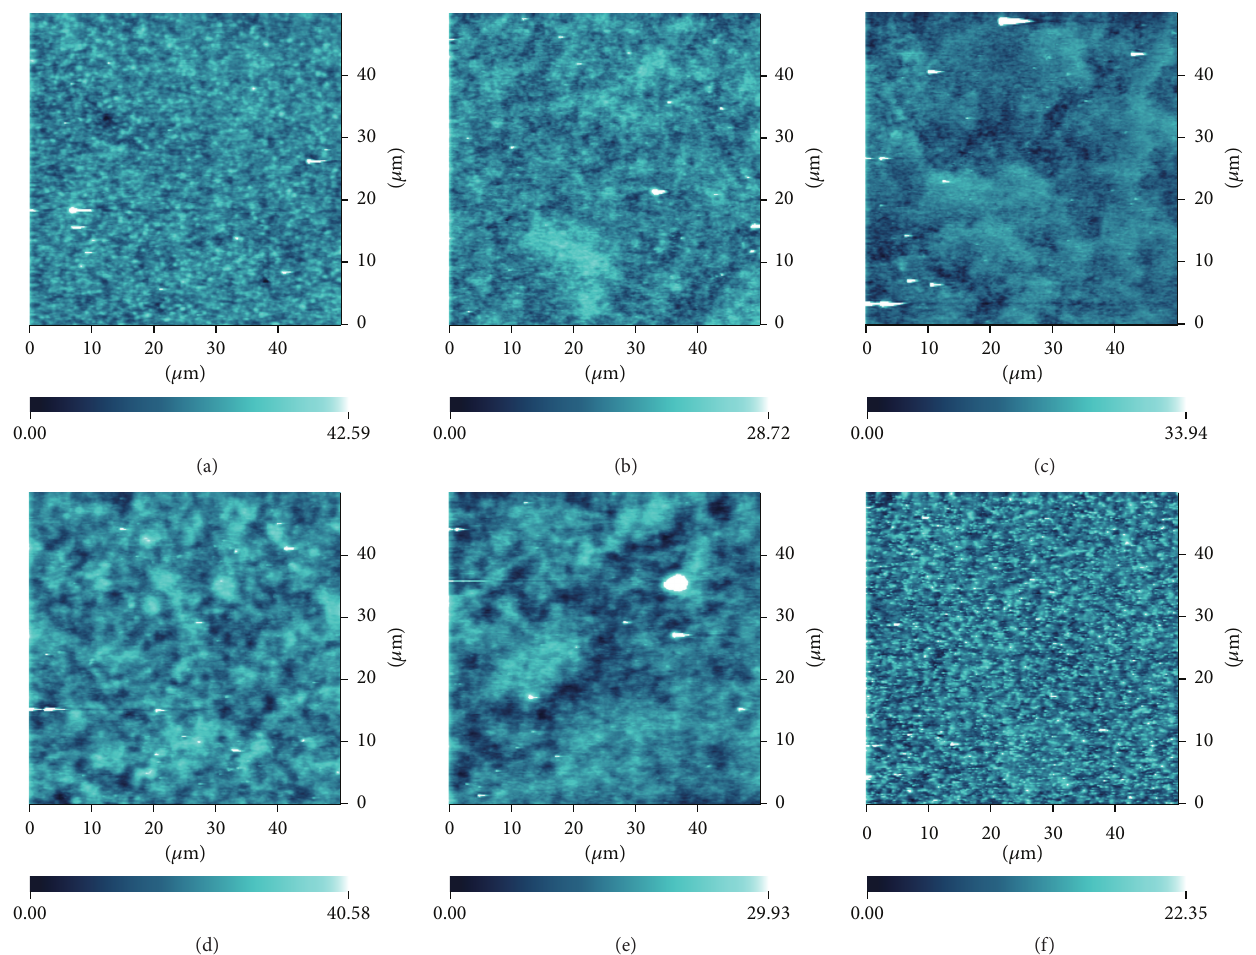
Figure 3: Representative topographies of PEDOT:PSS thin films coated at different flow rate from the PEDOT:PSS ink of 80 vol% DMSO and at a flow rate around 5 𝜇 L/min from other three